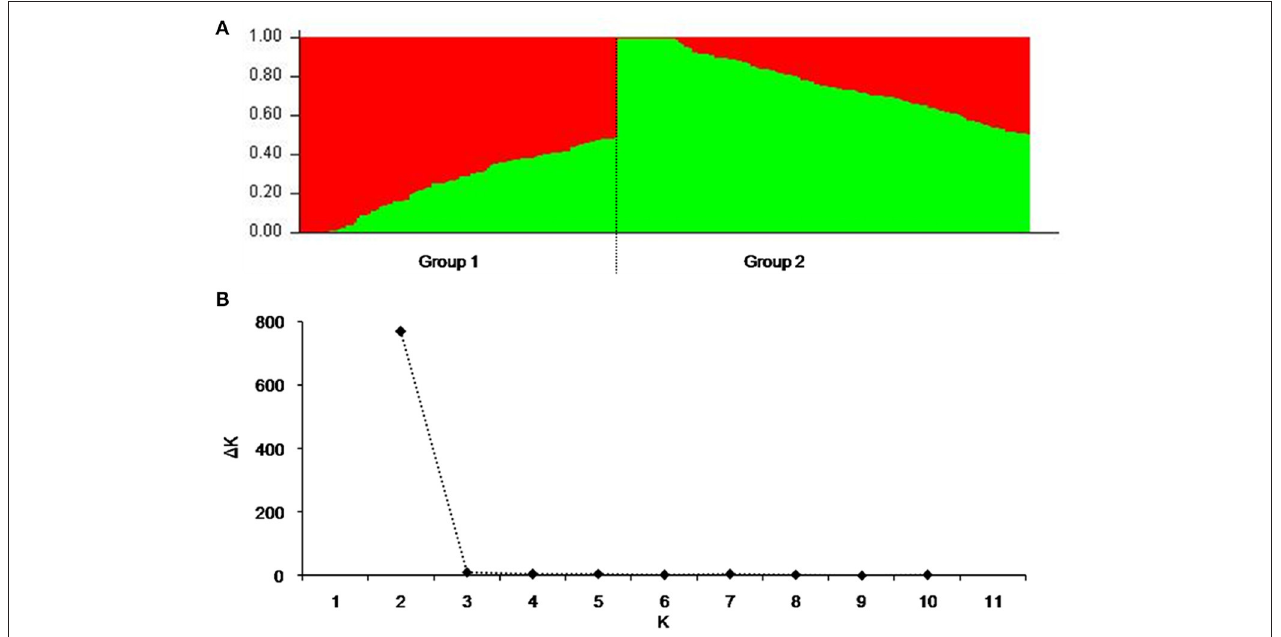
FIGURE 1 | Population structure of 264 released cultivars based on 3,656 SNP markers with a whole-genome coverage. (A) Genetic structure produced by Structure V2.3.2, (B) Number of sub-populations estimated by 1 K at a range of